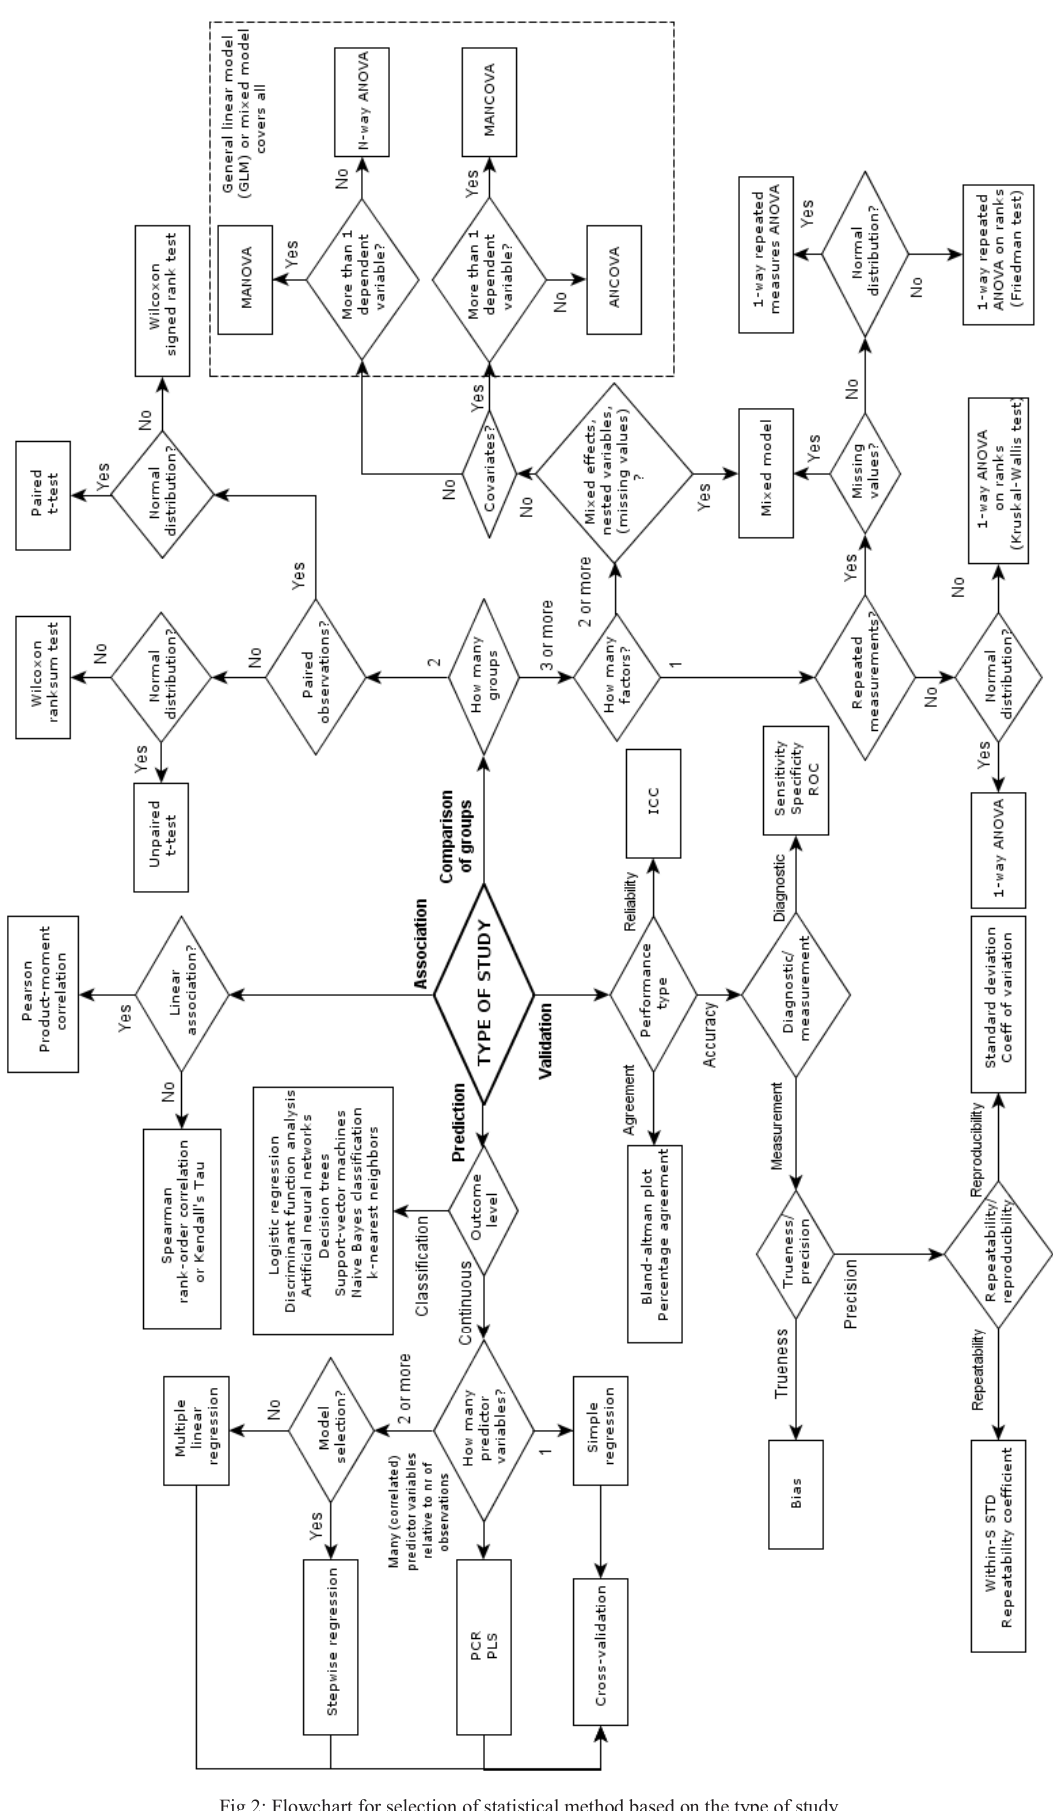
Fig.2: Flowchart for selection of statistical method based on the type of